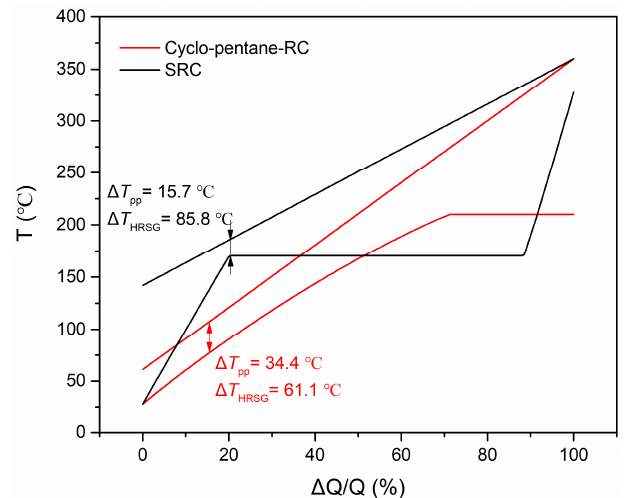
Figure 10. T-Q diagram between the heat source and working fluid.